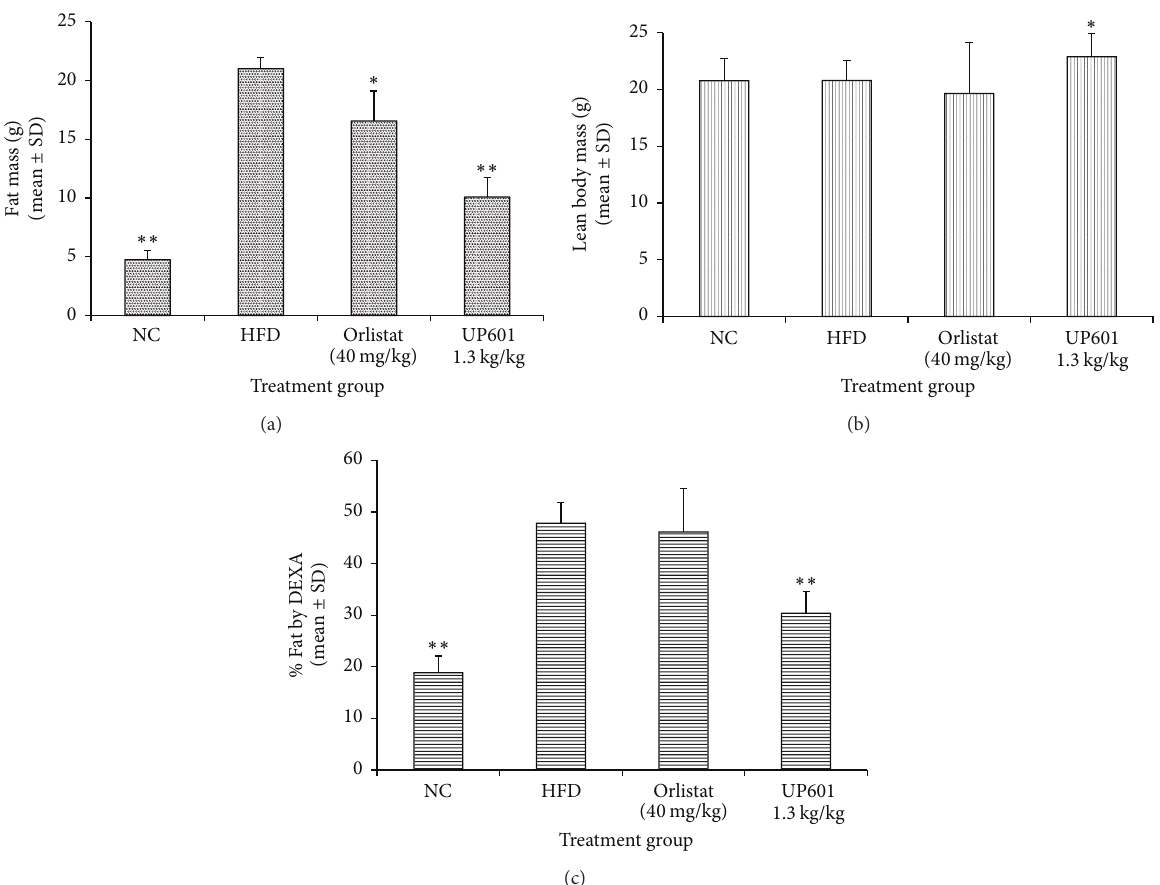
Figure 6: DEXA scan measurements for lean body and fat mass. (a) Fat mass, (b) lean body mass, and (c) percent fat relative to body weight. ∗∗ 𝑃 ≤ 0.0001 ; ∗ 𝑃 ≤ 0.001 .